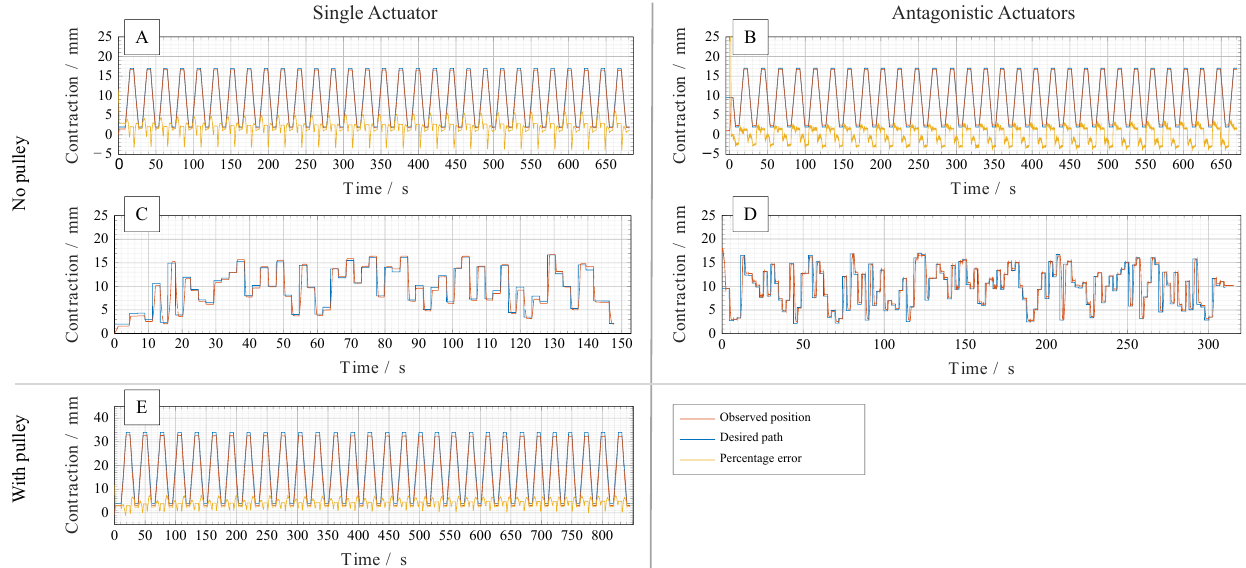
Figure 5. Results of path following tests for the one-DOF setup. ( A ) Single actuator, no pulley, min. to max. test, 30 repetitions. ( B ) Antagonistic actuators, no pulley, min. to max. test, 30 repetitions. ( C ) Single actuator, no pulley, random positioning. ( D ) Antagonistic actuators, no pulley, random positioning. ( E ) Single actuator, with pulley, min. to max. test, 30 repetitions.